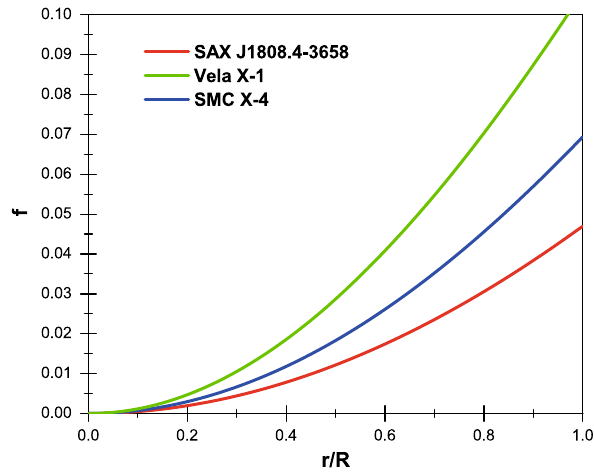
Fig. 1 The increasing behaviour of the deformation function f ( r ) against the fractional radial